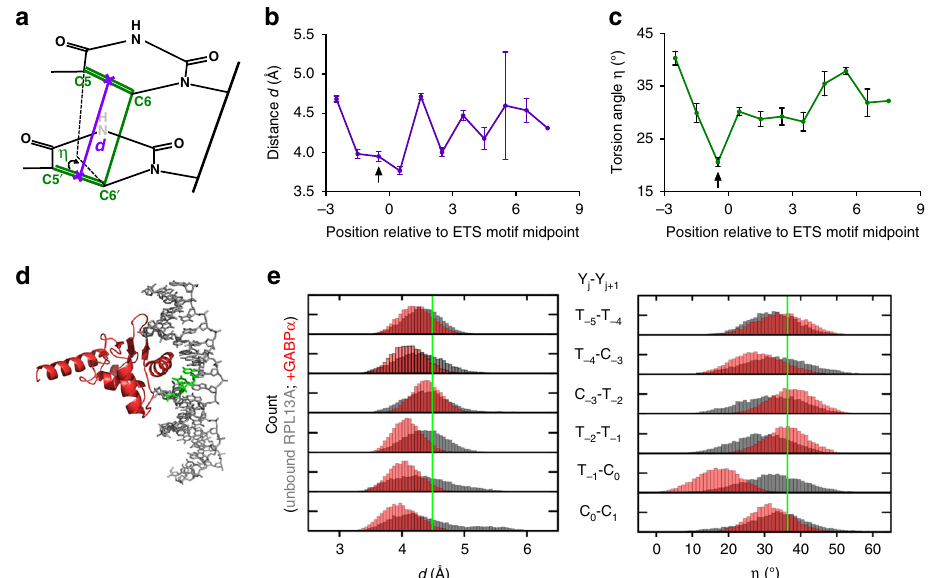
Fig. 6 ETS binding induces a DNA conformation predisposed to form CPD lesions. a Schematic showing the key structural parameters that affect the rate of CPD formation, namely the distance ( d ) between the midpoints of adjacent C5 – C6 bonds, and the torsion angle ( η ) between the adjacent C5 – C6 bonds. b , c Plots of distance ( d ) and torsion angle ( η ) between adjacent C5 – C6 bonds for structures of ETS bound DNA. The arrow indicates the location of the CPD hotspot at position − 1/0, corresponding to position − 0.5 in the plot. The mean ± SEM is plotted for data derived from thirteen crystal structures. d Structure of GABPA bound to DNA (PDB ID: 1AWC). The CPD hotspot at positions − 1/0 relative to the motif midpoint is highlighted in green. Image was visualized using pymol. e Molecular dynamics simulation of GABPA (i.e., GABP α ) bound to a 14 nt duplex DNA sequence containing ETS motif-2 in the RPL13A promoter. The distance ( d ) and torsion angle ( η ) between C5 – C6 bonds of adjacent pyrimidines was plotted for the fi nal 100 ns (10,000 frames). The distribution for GABPA-bound DNA is depicted in red, while simulated unbound DNA is shown in gray. Each increment in the ordinate represents 500 counts. Green lines indicate canonical values of B-form